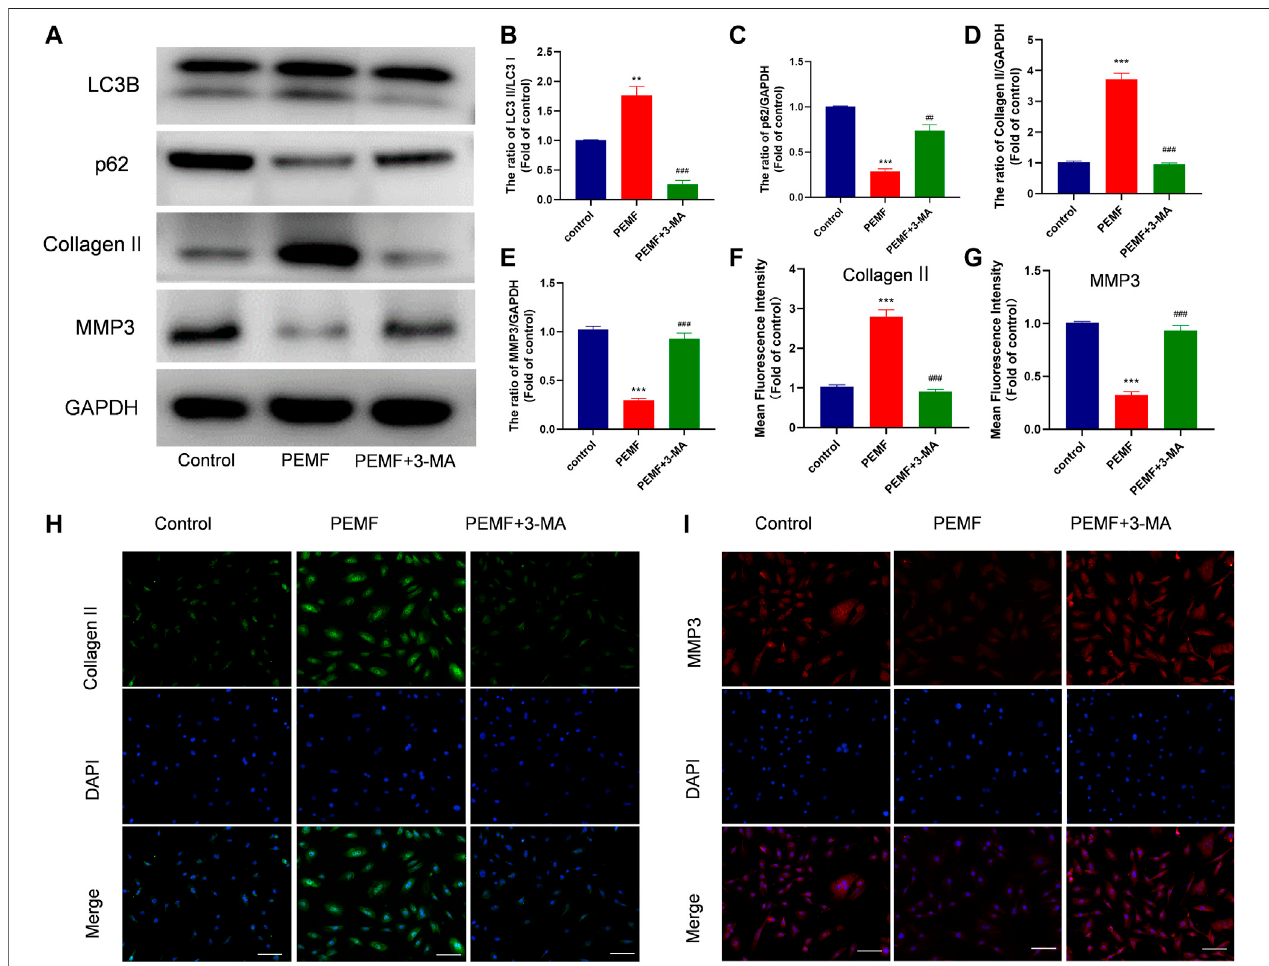
FIGURE 4 | PEMF regulates ECM related makers expression via autophagy (A – E) Western blot and semi-quantitative analyses of Collagen II, MMP-3, p62, and LC3B protein levels (n = 3). (F – I) Representative images of immuno fl uorescence and semi-quantitative analyses of Collagen II and MMP-3 fl uorescence intensity in NP cells, imaged by fl uorescence microscopy (scale bar = 50 μ m). ** p < 0.01 vs. control, *** p < 0.001 vs. control, ## p < 0.01 vs. PEMF, ### p < 0.001 vs. PEMF. Data presented as means ± SD.